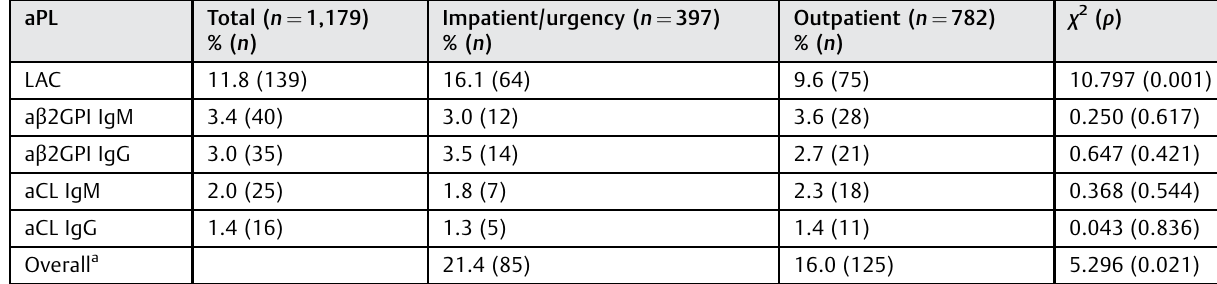
Table 3 aPL ’ s positivity prevalence by sample source aPL Total ( n ¼